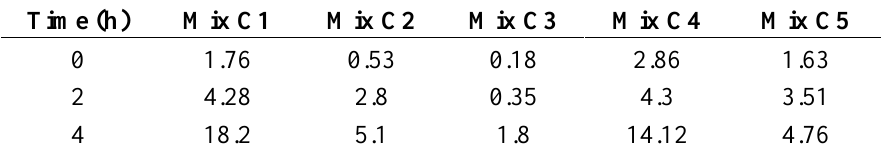
Table 4. Volume fraction of permanent coagulation (%).